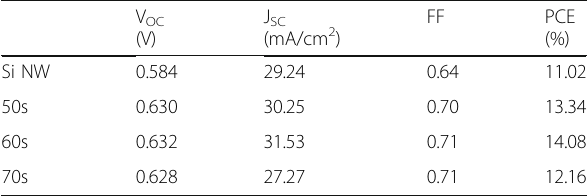
Table 1 Solar cell efficiency and J – V parameters of the PEDOT:PSS/Si solar cells with different treatment